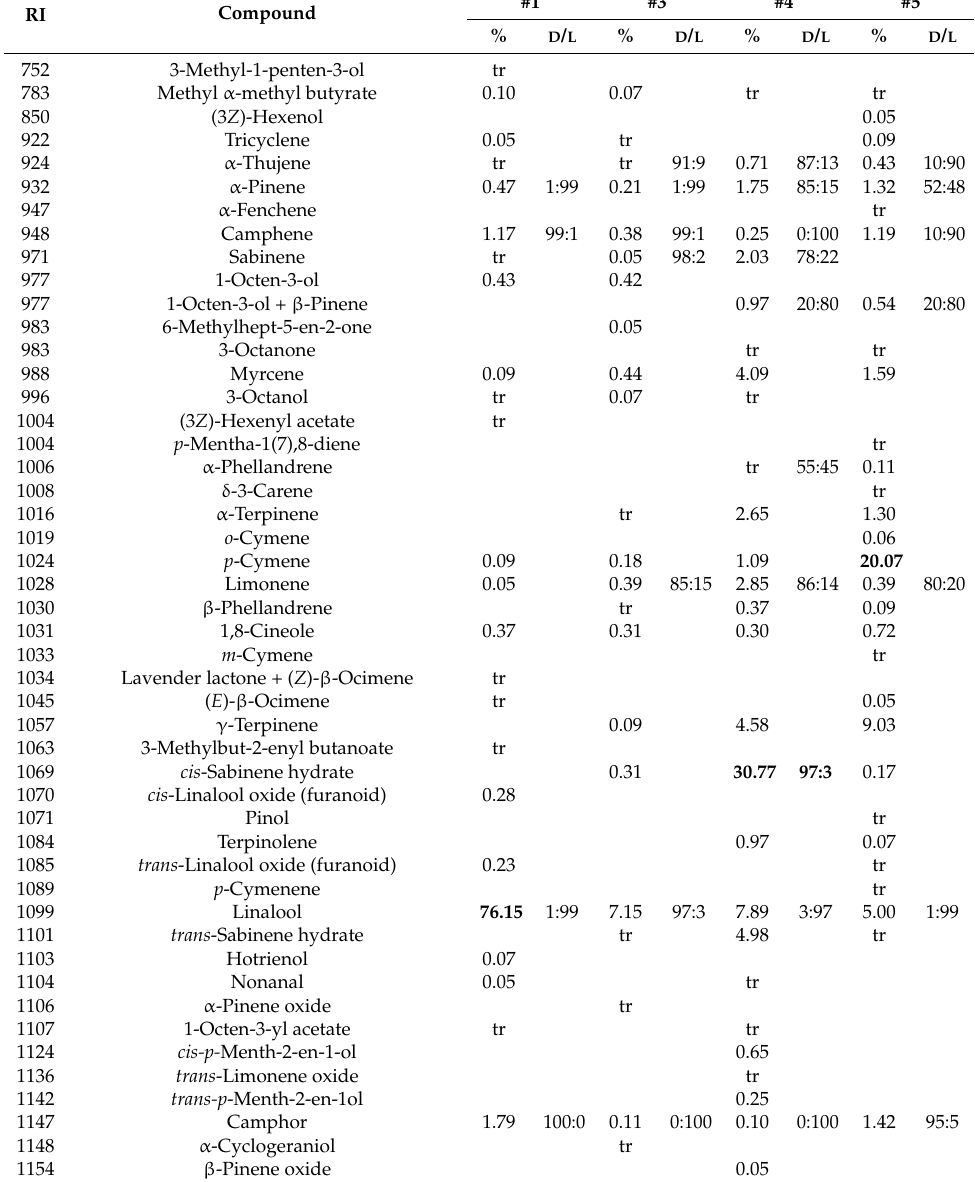
Table 1. Chemical compositions and enantiomeric distributions of Thymus vulgaris essential oils. RI